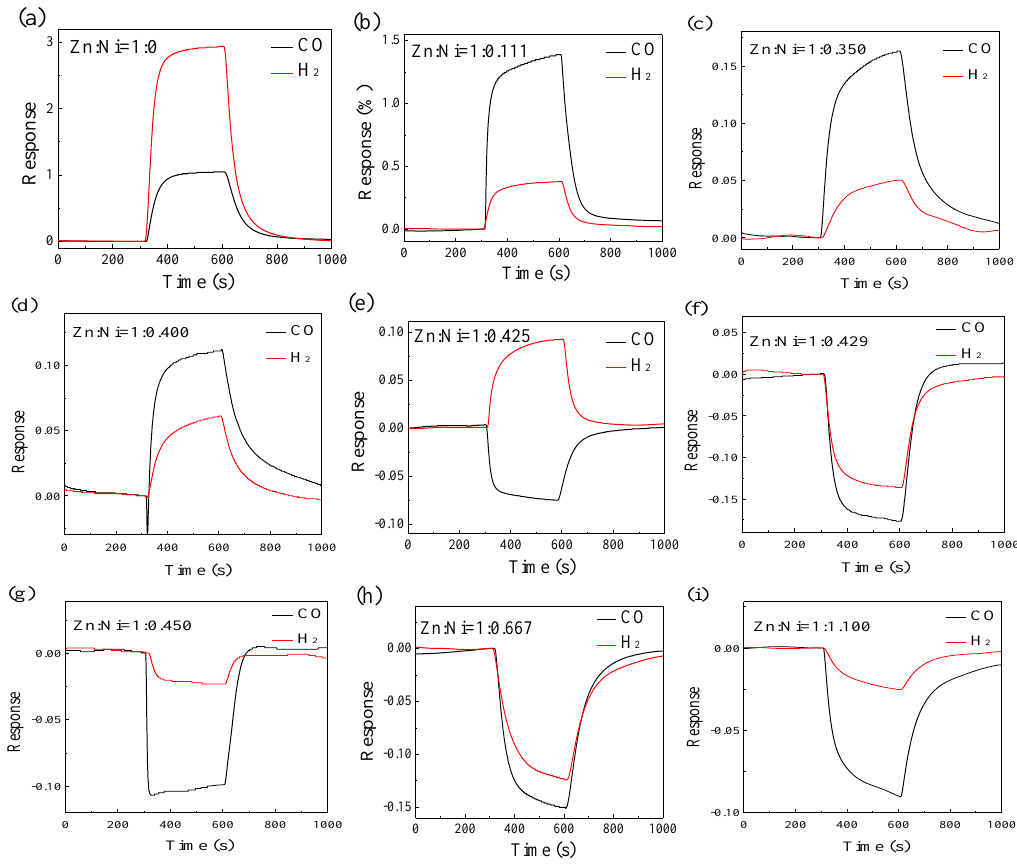
Figure 6. Responses of ZnO ( a ) and ZnO– x NiO ( x = 0.111, 0.350, 0.400, 0.425, 0.429, 0.450, 0.667, 1.100) ( b – i ) annealed at 550 ◦ C to 400 ppm CO and H 2 at the operating temperature of 350 ◦ ( b – i ) annealed at 550 °C to 400 ppm CO and H 2 at the operating temperature of 350 °C.